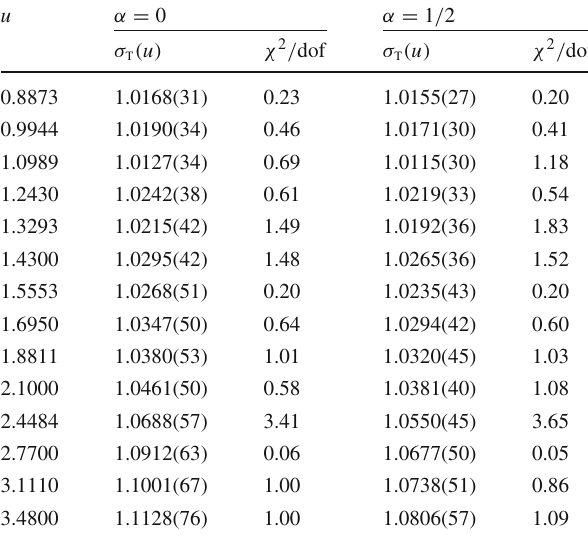
Table 6 Continuum-extrapolated values for the SSFs for N f = 0